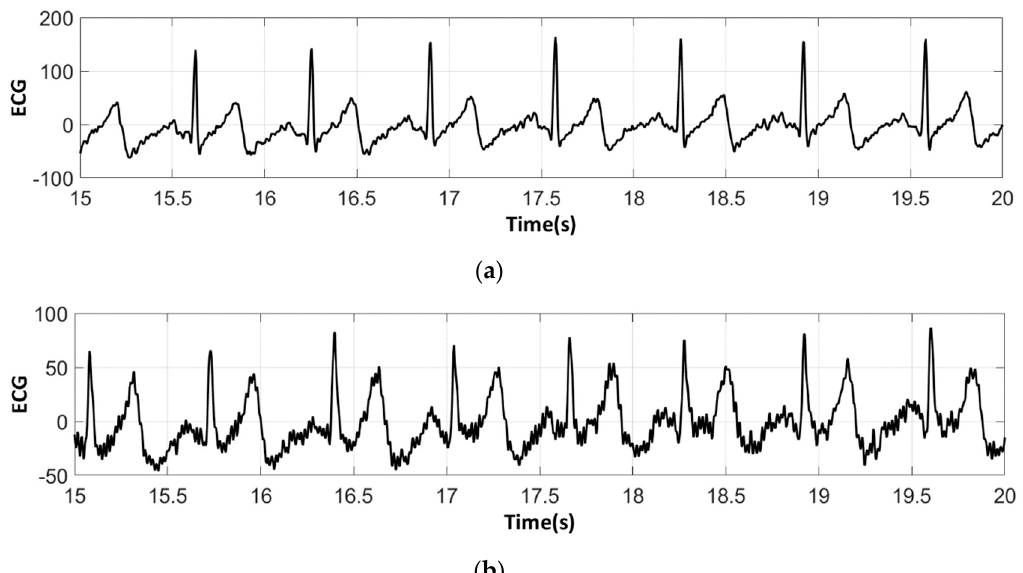
Figure 16. ECG signal obtained by 100% cotton electrodes with 12.8 wt.% PEDOT:PSS: ( a ) before washing; ( b ) after 50 washing cycles.